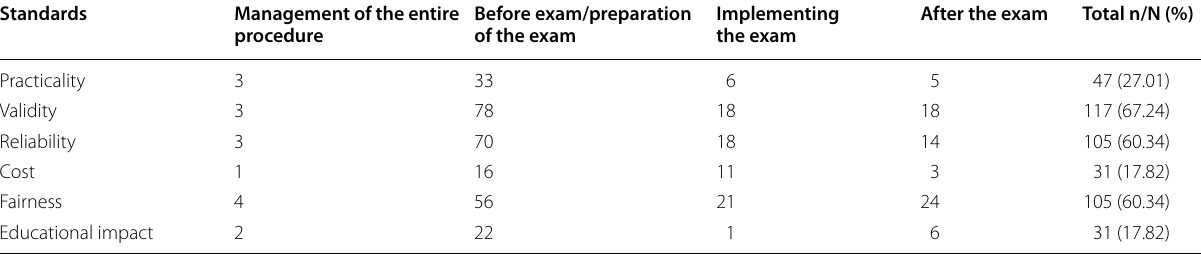
Table 6 Distribution of items according to the assessment standards and main titles (N